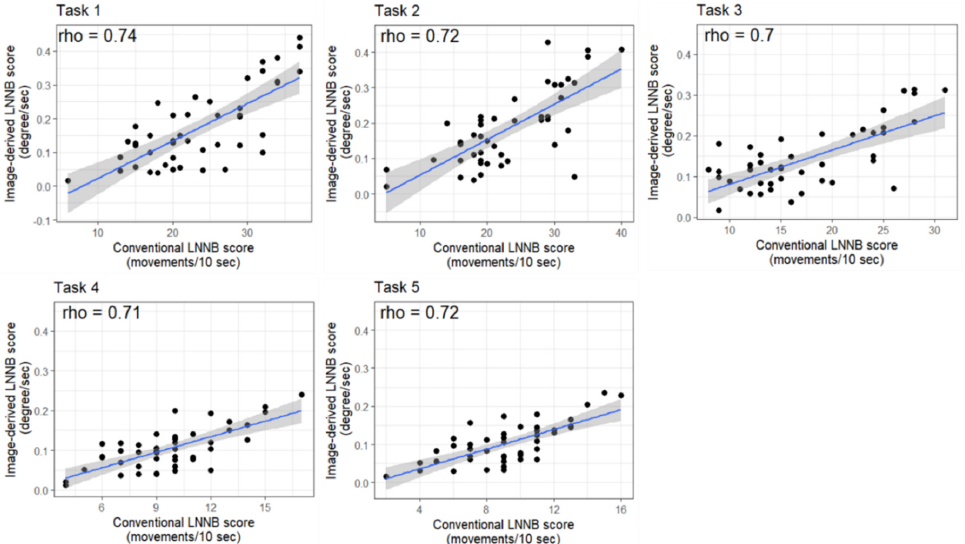
Figure 1. Scatterplots, Pearson correlation coefficients (rho) and linear trends of the relationship between the conventional (x-axis) and the image-derived (y-axis) Luria-Nebraska Neuropsychological Battery (LNNB) task scores. Each dot represents an individual, the black line represents the linear trend of the association between conventional and the image-derived LNNB task scores, and the grey shade indicates the 95% Confidence Interval of the linear trend. Task 1: the dominant hand clench, Task2: the finger–thumb touching with the dominant hand, Task 3: the non-dominant hand clench, Task 4: the finger–thumb touching with non-dominant hand, Task 5 alternative hand clench.